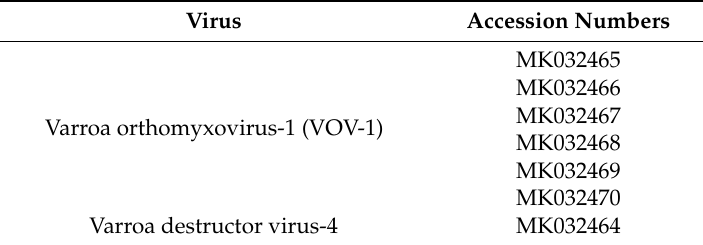
Table 2. Accession numbers for the new